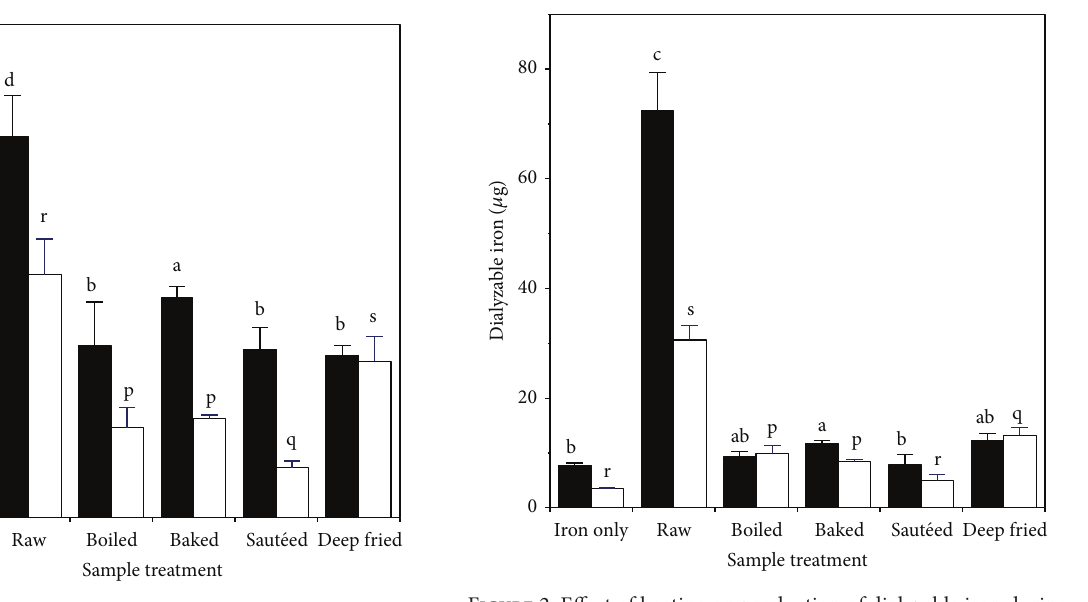
Figure 1: Effect of heating on production of dialyzable iron during extraction of chicken muscle: ◼ total dialyzable iron; ◻ ferrous dialyzable iron. Values are the mean ± standard deviation ( 𝑛 = 10 ). Means in the same group ( ◼ or ◻ ) without a common letter differ at 𝑃 < 0.05 .